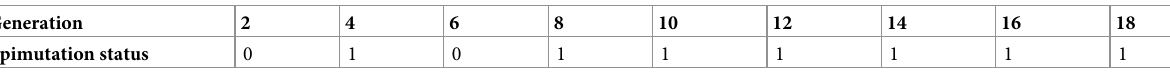
Table 5. Gene expression status for ugt-26 .